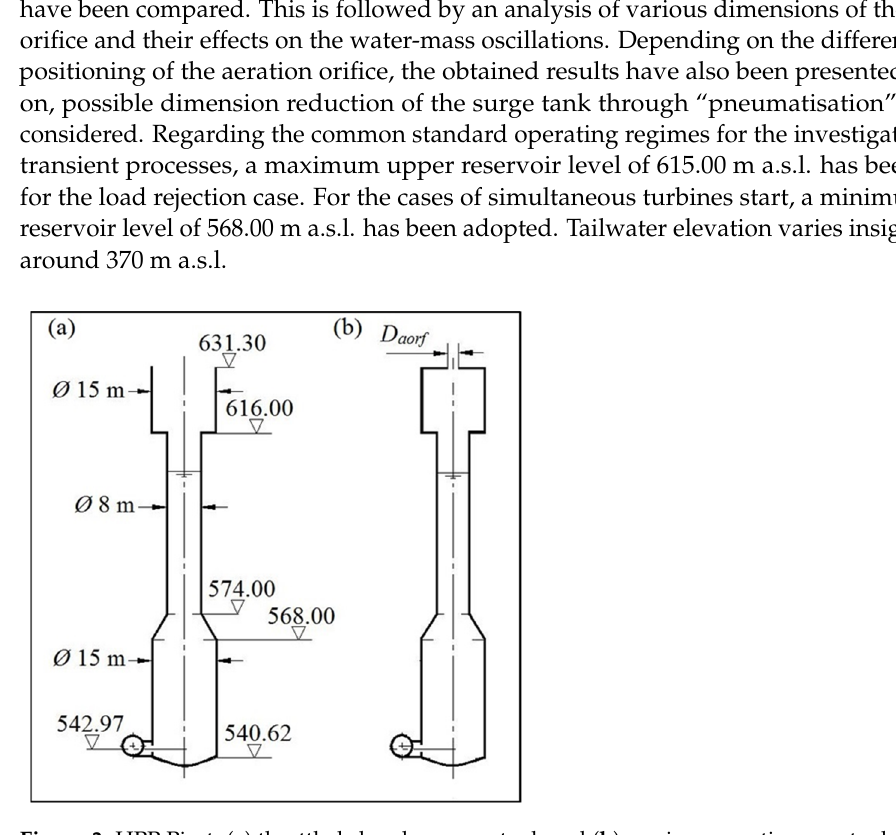
Figure 3. HPP Pirot: ( a ) throttled chamber surge tank and ( b ) semi-pneumatic surge tank developed for the comparison (levels are indicated in m a.s.l.).